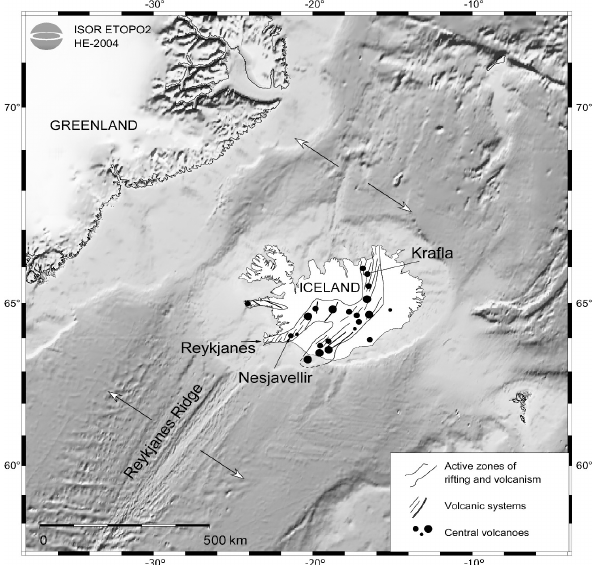
Figure 1. The location of Iceland on the Mid-Atlantic Ridge. The arrows show the spreading directions on the Reykjanes ridge to the south and the Kolbeinsey Ridge to the north. Iceland’s neo- volcanic zone with its active central volcanoes and the location of the three high-temperature hydrothermal systems of Reykjanes, Nesjavellir (in the Hengill volcano), and Krafla, targeted for IDDP deep drilling, are also